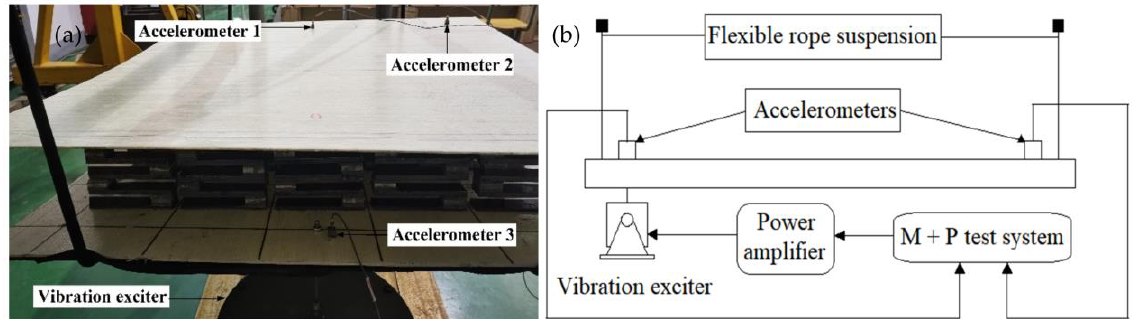
Figure 10. ( a ) The experimental setup. ( b ) The experimental measurement principle.